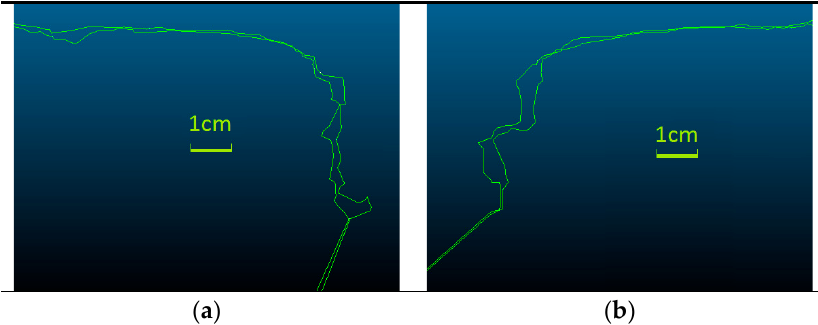
Figure 8. Left ( a ) and right ( b ) rail double edges on one cross-section generated by PhotoScan.